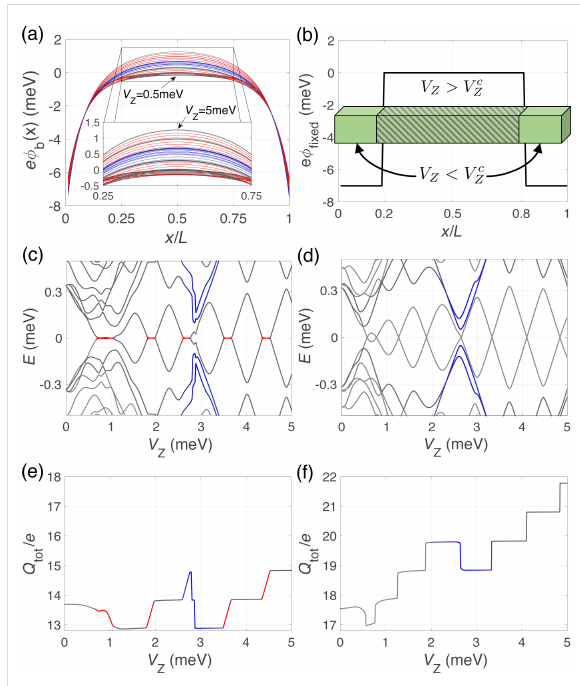
Figure 5: Majorana nanowire subject to interactions from the electro- static environment (including the influence of the bulk normal leads at its ends). (a) Self-consistent induced potential energy along the length of the wire for increasing values of the Zeeman splitting. The same wire parameters as in Figure 2 were used. Note that the main effect of the bulk normal leads is to create confining potential wells at the wire edges. (b) Barrier-like potential energy profile used to mimic the self-consistent solution. Spectra of the Majorana nanowire as a function of V Z in the (c) interacting case and in the (d) non-interacting case but using the potential profile model of (b). (e, f) Evolution of the total charge Q tot with Zeeman splitting for the two previous cases, re- spectively. Red color indicates incompressible electron fluid behavior as before, while blue color indicates QD-like behavior due to the metallic